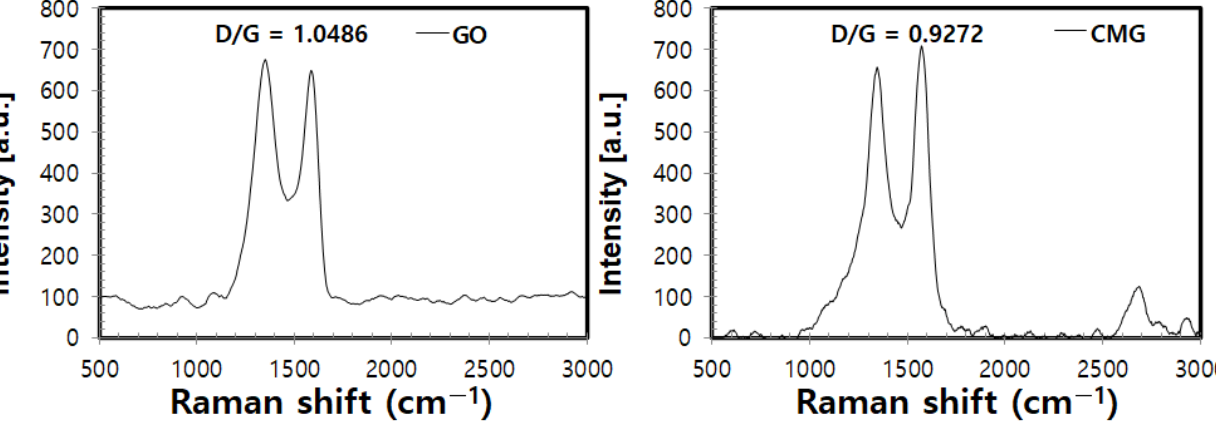
Figure 2. Raman spectra of GO and CMG fabricated by the improved method.